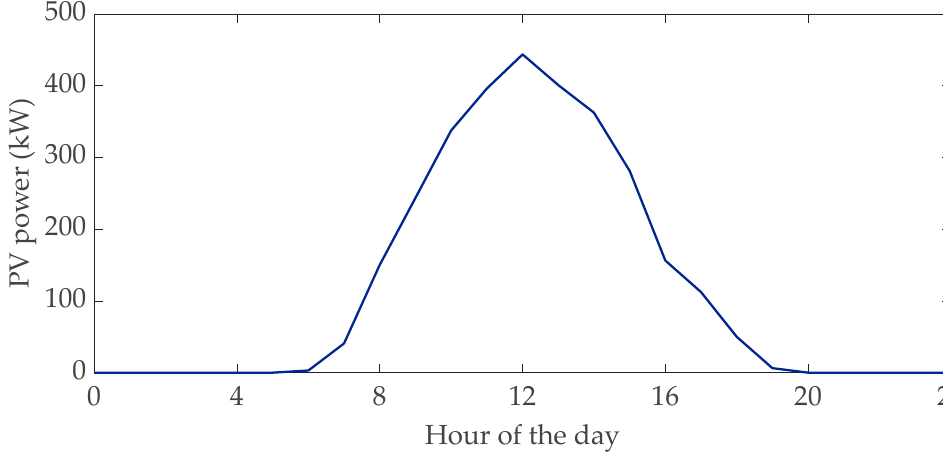
Figure 4. Daily profile of the loads connected at bus #6.